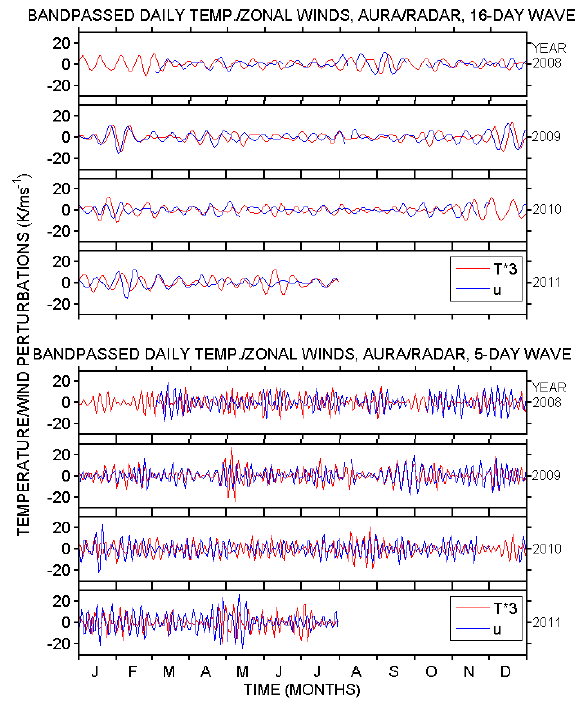
Fig. 10. Band-passed radar winds and Aura daily temperatures over BLO at ∼ 90km for the years 2008–2011. Band-pass limits are for the wave periods of 12–20 days and 4–7 days for the 16- and 5-day wave, respectively. The Aura MLS data is from 40–45 ◦ N and 90– 120 ◦ W. Note the temperatures have been multiplied by a factor of 3 to help comparison with the winds.